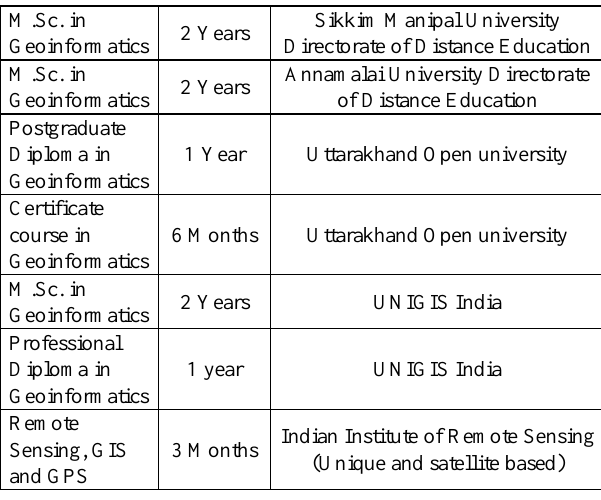
Table 2. Distance Education Programs in India Table 3 provides details of some GIS courses offered